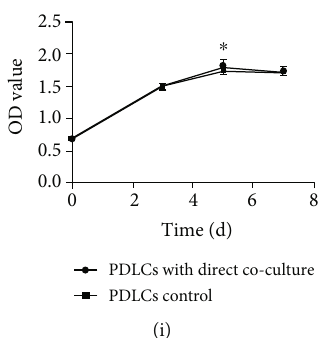
Figure 1: Expression of GFP in PDCs and PDLCs, and the proliferation rate of PDCs and PDLCs. GFP was visually detected in lentivirus- transduced clones after transduction (a). The e ffi ciency of lentivirus transduction was 89 : 3 % ± 1 : 5 % in DPCs and 91 : 3 % ± 1 : 9 % in PDLCs at a multiplicity of infection (MOI) of 100 (b). Representative images of DPCs and PDLCs were taken with upright fl uorescence microscope at di ff erent time points (c). DPCs (GFP+), PDLCs (BrdU+), and DPCs (GFP+) plus PDLCs (BrdU+) were seeded and incubated into tissue culture plates for 3, 5, and 7 d, respectively. Data was presented in the histogram (d, e). The proliferation rates of cocultured DPCs (GFP+) and PDLCs (BrdU+) were signi fi cantly reduced ( ∗∗ P < 0 : 01 , ∗∗∗ P < 0 : 001 , and ## P < 0 : 01 ). The proliferation rate of DPCs and PDLCs with indirect or direct coculture was signi fi cantly reduced on day 5 as compared with control cells (f, g, h, and i, ∗ P < 0 : 05 and ∗∗ P < 0 : 01 ). Scale bars = 100 μ m